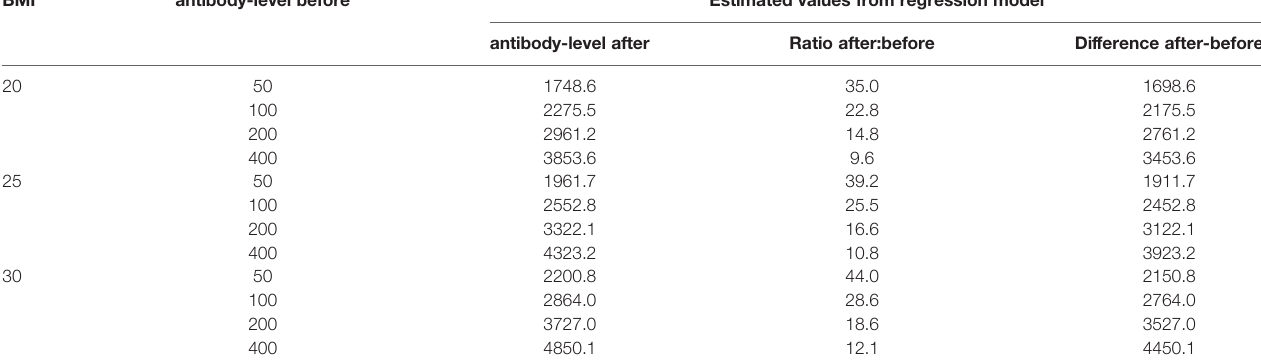
TABLE 4 | Estimates for different selected values.